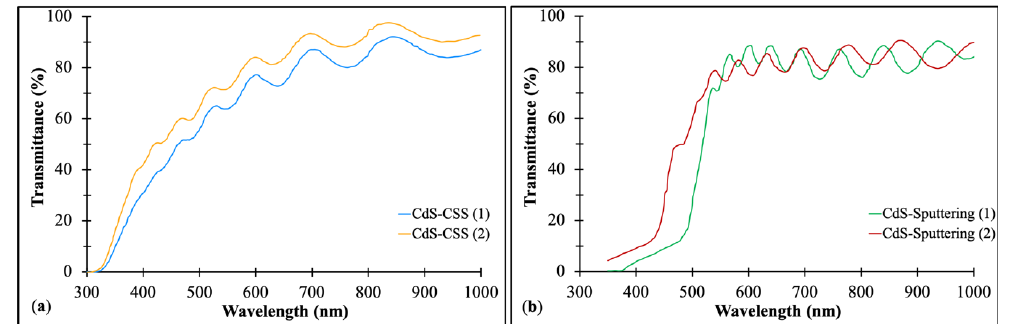
Figure 8. Transmittance spectra of: ( a ) 300 nm thick CdS film prepared by CSS in Ar + O 2 atmosphere: (1) as-deposited, (2) after annealing for 30 min at 420 °C in 400 mbar of Ar containing 20% of H 2 ; ( b ) 80 nm thick sputtered CdS film: (1) deposited in pure argon and (2) deposited in argon + CHF 3 . The shift toward shorter wavelengths of the absorption edge demonstrates the helpful effect of deposition in the presence of